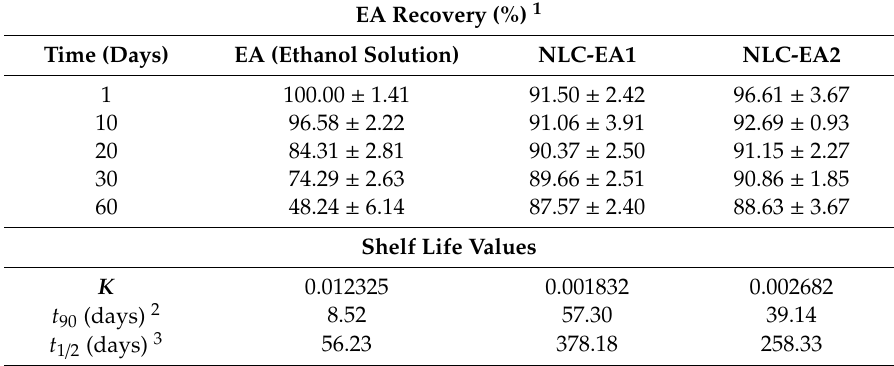
1 : percentage as a function of initial EA content by weight. 2 : time at which the drug concentration has lost 10%. 3 : time at which the drug concentration has lost 50%. The results are the average of three independent experiments ±